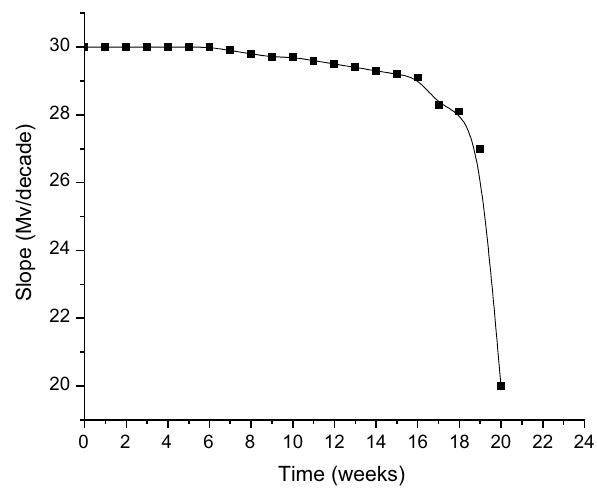
Fig. 7 Lifetime of the Hg(II) modified SPE sensor